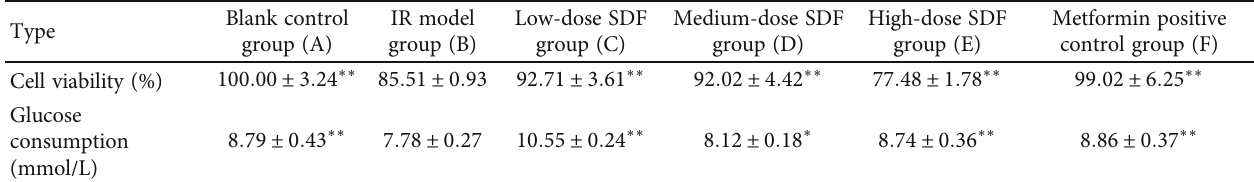
Table 4: The e ff ect of fresh rice leaf SDF on the growth and glucose consumption of IR in HepG2